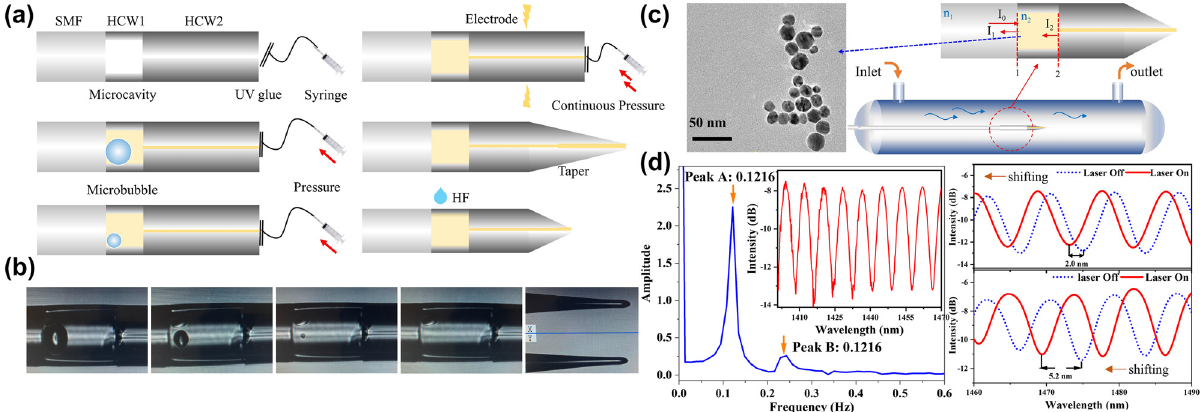
Figure 7: Fabrication of the flowmeter: (a) Fabrication process of the fiber-tip flowmeter probe. (b) Images of the fabrication process. (c) Schematic diagram of the fiber-tip flowmeter probe; the inset is the TEM images of silver nanoparticles solution. (d) FFT and reflection spectra of sensor probe; reflection spectra before and after immersed in liquid with the pump